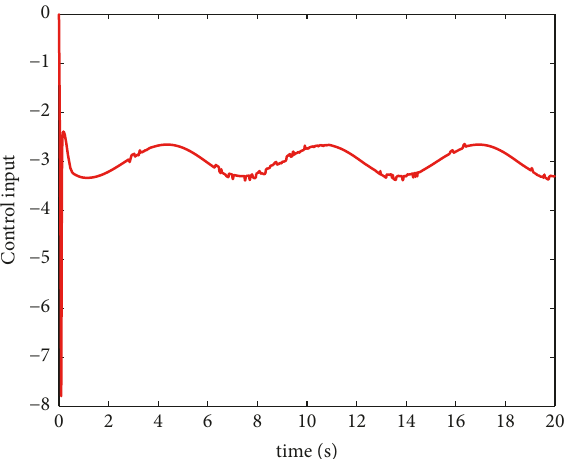
Figure 11: The control input of NNSMC with 𝑥 𝑑 = 0.1 sin (𝑥) .